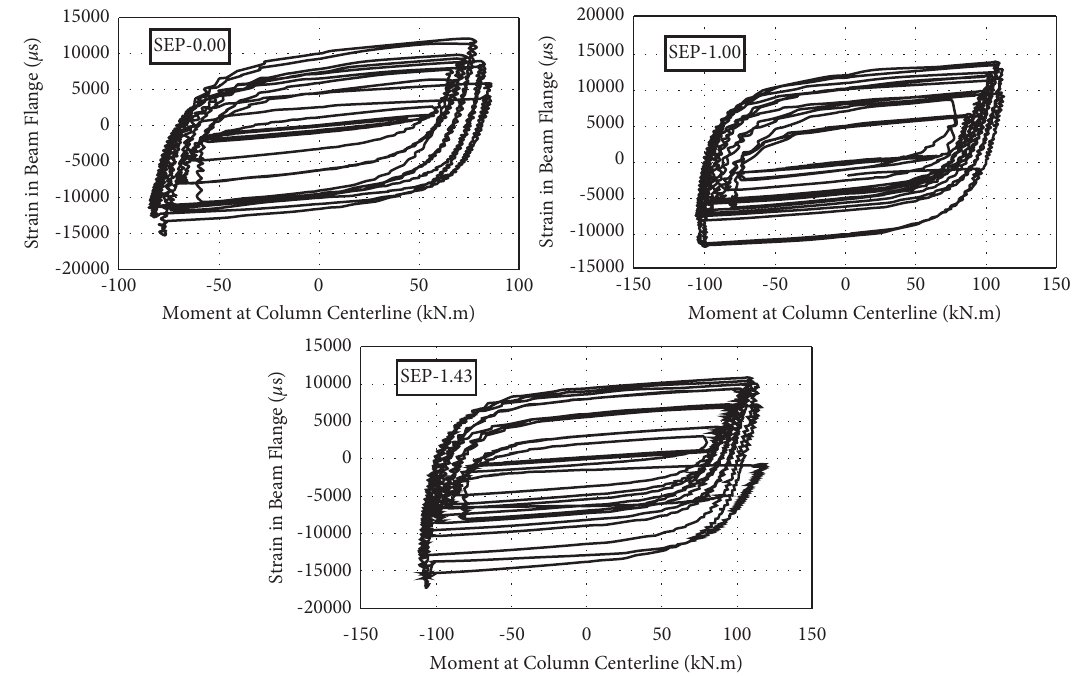
Figure 6: Strain variation history in beam